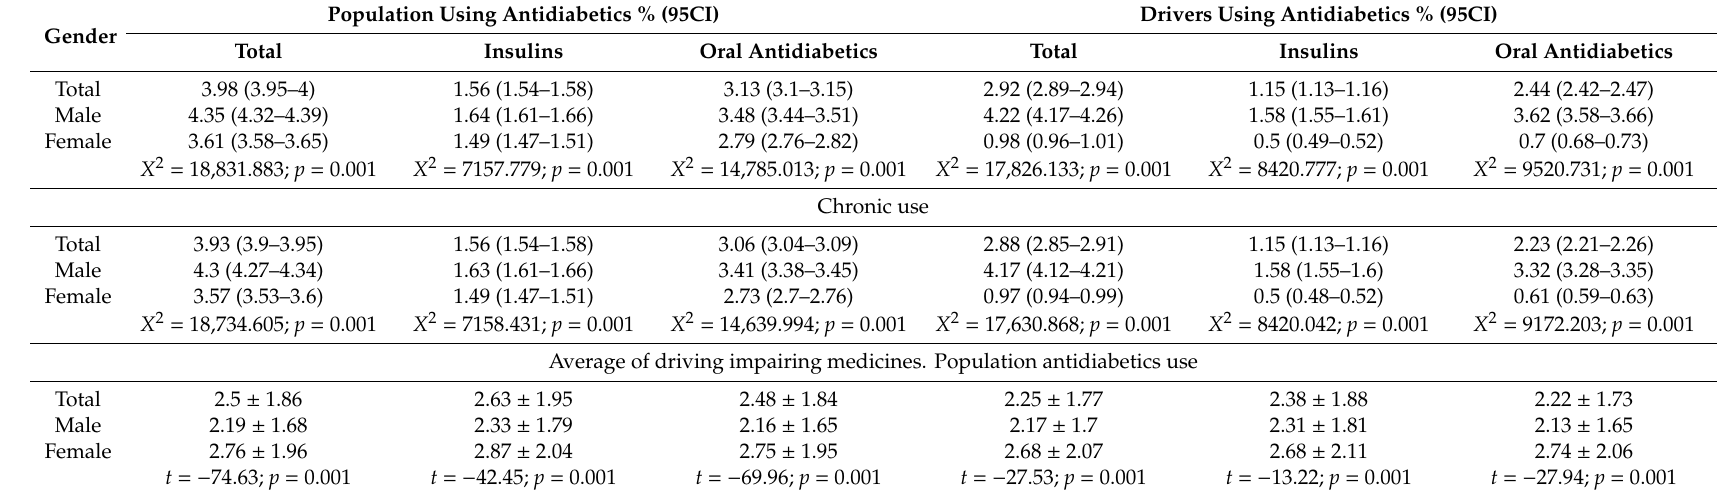
Table 1. Consumption of antidiabetics according to CONCYLIA database and the Castile and Le ó n drivers’ license census